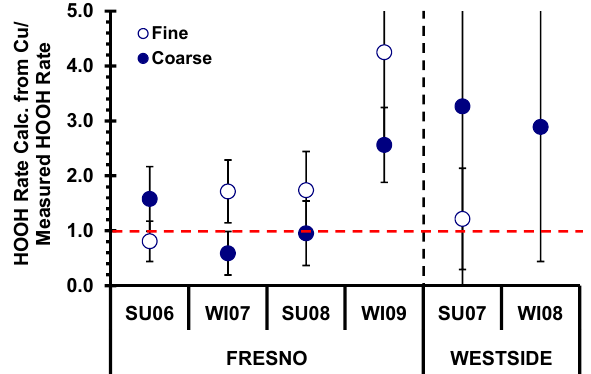
Fig. 7. Contribution of SLF-soluble Cu to the initial rate of HOOH generation in SLF with Asc. Each point represents the ratio of the initial rate of HOOH formation expected from the measured con- centration of Cu in the SLF extract of the PM to the initial rate of HOOH formation measured for the sample. Values are means ± SD. n = 4 to 6 for the calculated HOOH rate from Cu, n = 3 for the measured HOOH rate. The Westside winter 2008 fine PM data point is not shown because HOOH generation in this sample was not significantly different from